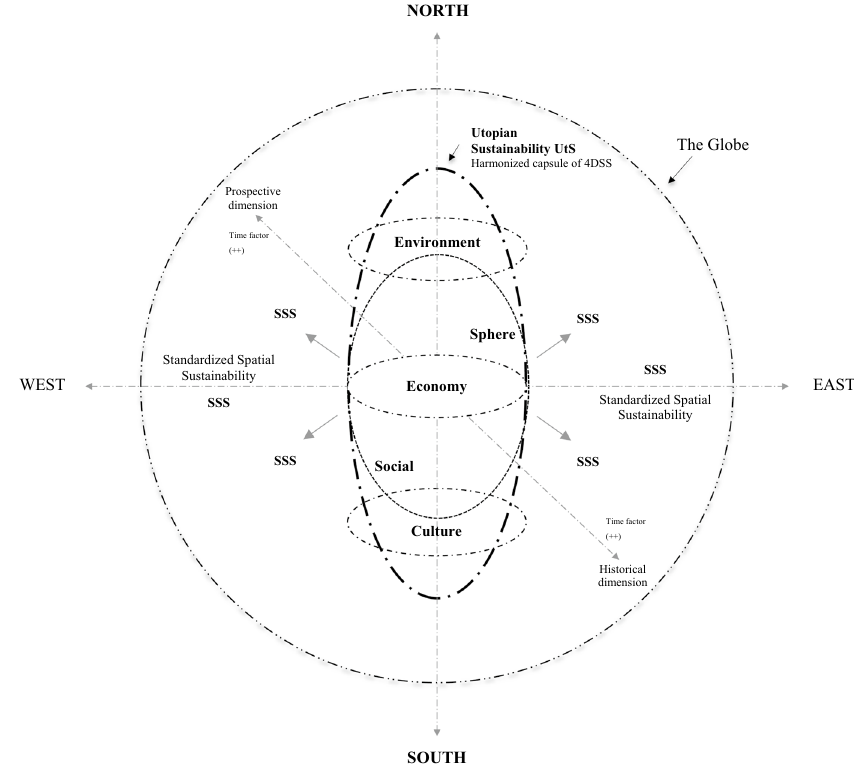
Fig. 7 Model 4: Utopian Sustainability (UtS): Perfect standardized spatial sustain- ability (3S) resulting demo- cratically by spatial participa- tive sustainability (SPS) on global scale–long term impact model